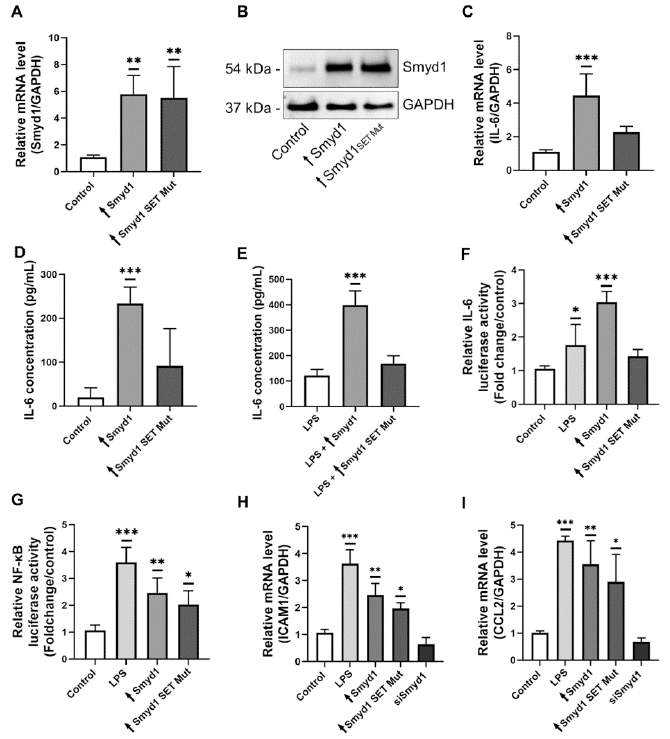
Figure 5. The methyltransferase activity of Smyd1 regulates IL ‐ 6 expression . ( A , B ) RT ‐ qPCR for the quantification of Smyd1 mRNA levels ( A ) and immunoblotting for determination of Smyd1 protein levels ( B ) in total lysates of EA.hy926 cells transfected with the pCMV2 ‐ Smyd1 ‐ flag vector ( ↑ Smyd1) or the Smyd1 ‐ SET ‐ mutant vector ( ↑ Smyd1 SET Mut). Expression values relative to control (transfection with vector lacking gene insert). n = 3, ** p < 0.01 using one ‐ way ANOVA. Representative immunoblot of n = 3. ( C ) RT ‐ qPCR for the quantification of IL ‐ 6 mRNA levels in EA.hy926 cells transfected with the pCMV2 ‐ Smyd1 ‐ flag vector ( ↑ Smyd1) or the vector with a Smyd1 gene insert expressing a point mutation within the SET domain ( ↑ Smyd1 SET mutant). Expression values relative to control (transfection with vector lacking gene insert). n = 5, *** p < 0.001 using one ‐ way ANOVA. ( D , E ) ELISA for the determination of IL ‐ 6 concentrations in supernatants of non ‐ stimulated ( D ) and 1 μ g/mL LPS ‐ stimulated ( E ) EA.hy926 cells transfected with a pCMV2 ‐ Smyd1 ‐ flag vector ( ↑ Smyd1) or Smyd1 ‐ SET ‐ mutant vector ( ↑ Smyd1 SET Mut). n = 5, *** p < 0.001 using one ‐ way